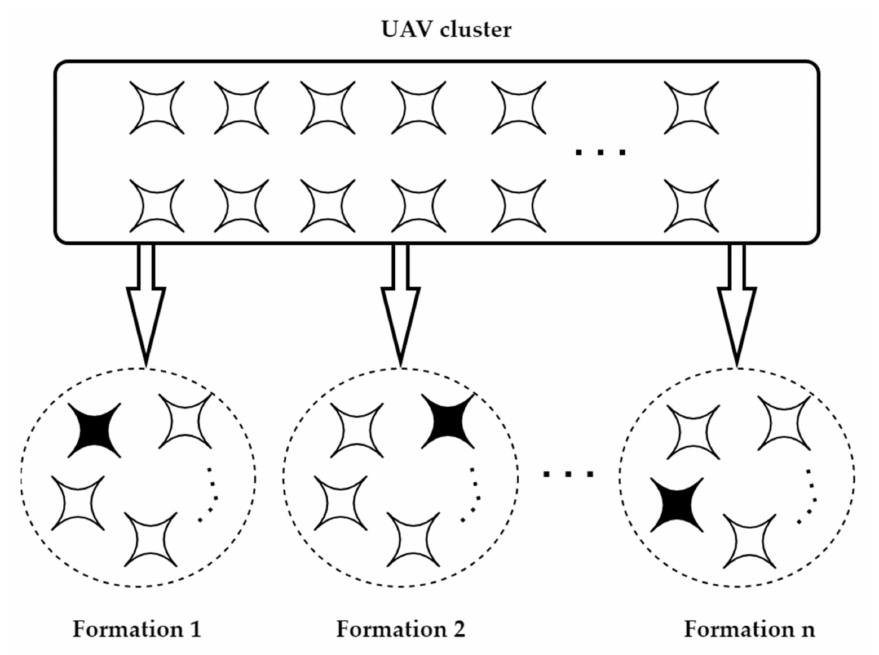
Figure 3. Grouping strategy based on UAV